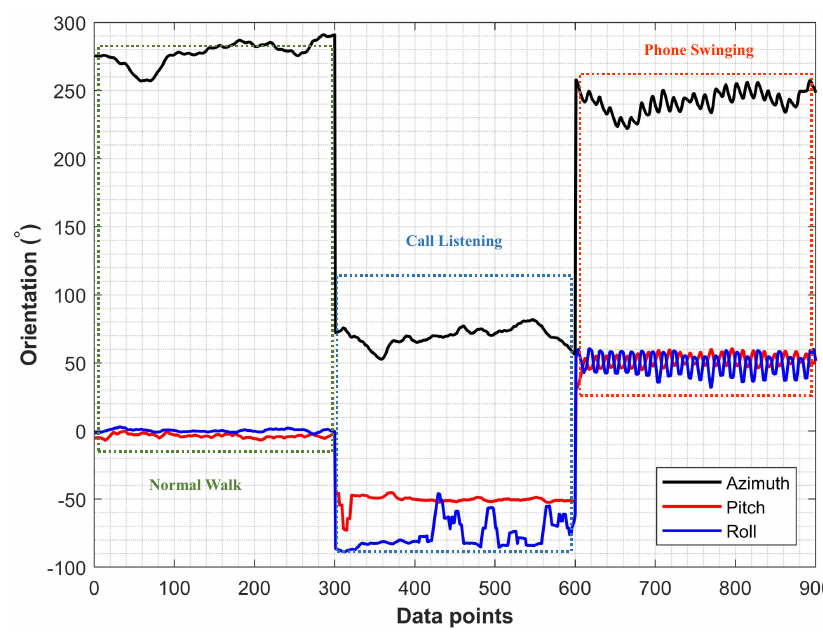
Figure 9. The phone orientation data for user